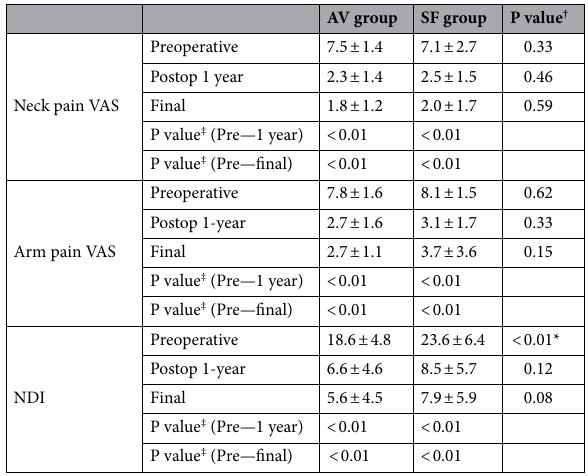
Table 4. Patient reported outcome measure results. AV all variable, SF selective fixed, VAS visual analogue scale, NDI neck disability index, pre preoperative. † Comparison between two groups were performed by student’s t-test. ‡ Comparison between preoperative and postoperative values were performed by paired t-test. *P < 0.05.